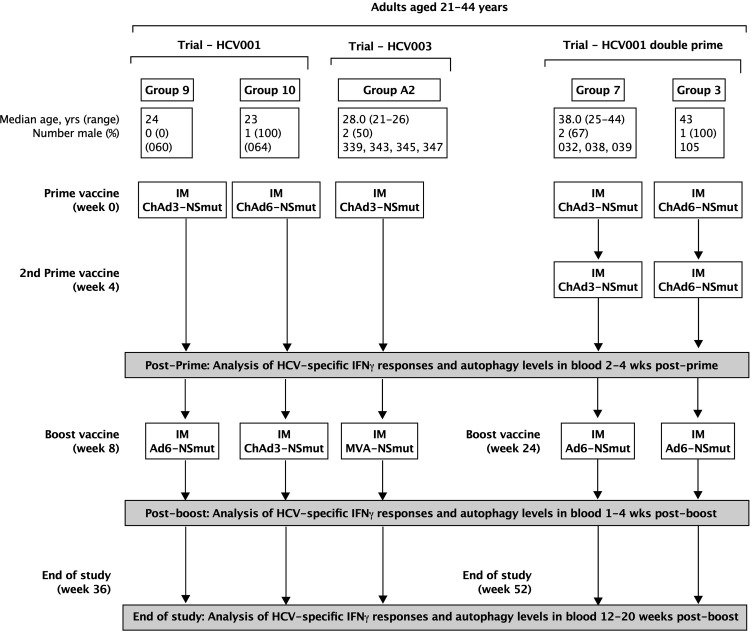
Regimen of immunizations and blood sampling for HCV trail.HCV = Hepatitis C virus, ChAd = Chimpanzee Adenoviral Vector, MVA = Modified Ankara Virus vector.